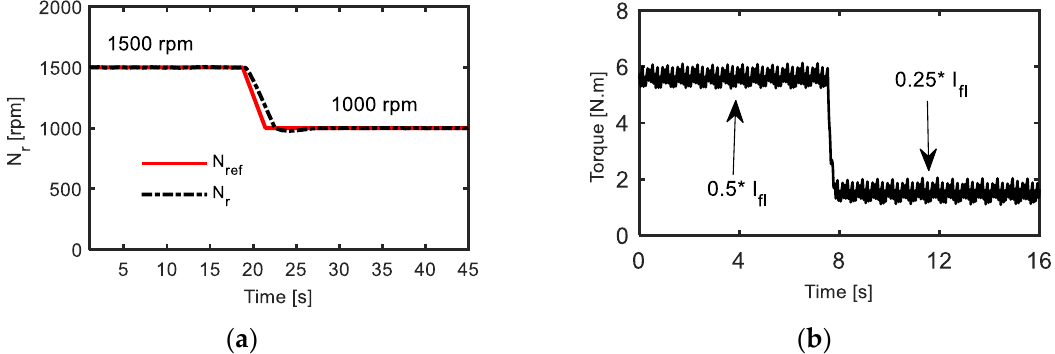
Figure 17. The performance of the drive system working at ( a ) speed control mode and ( b ) torque control mode.